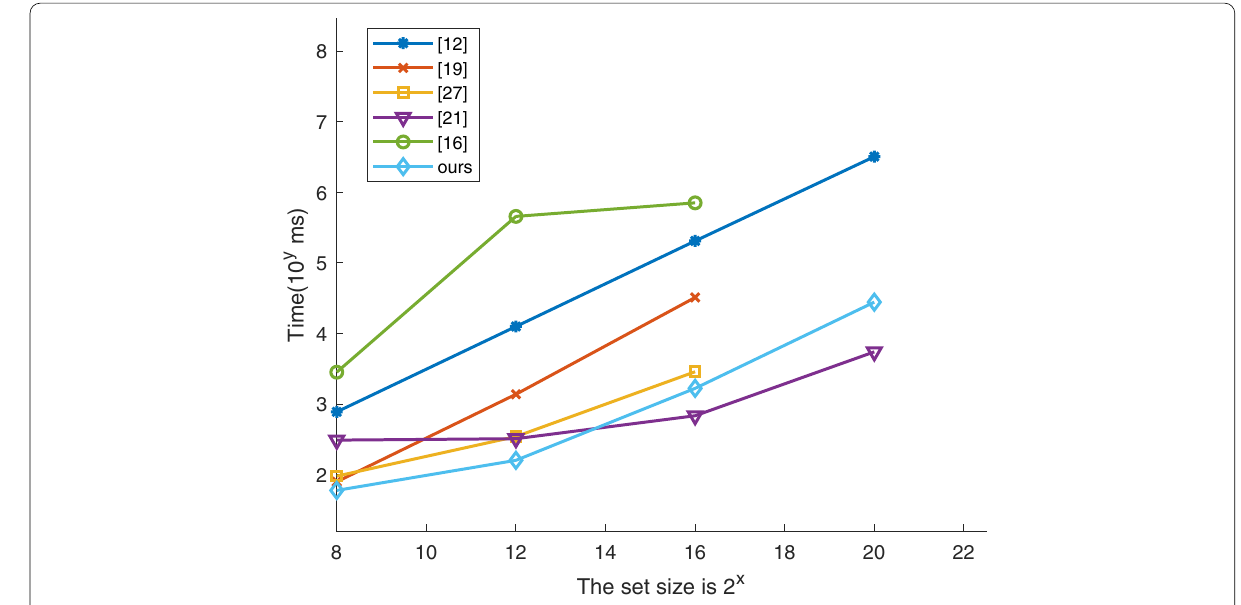
Fig. 5 Running time of related PSI protocols